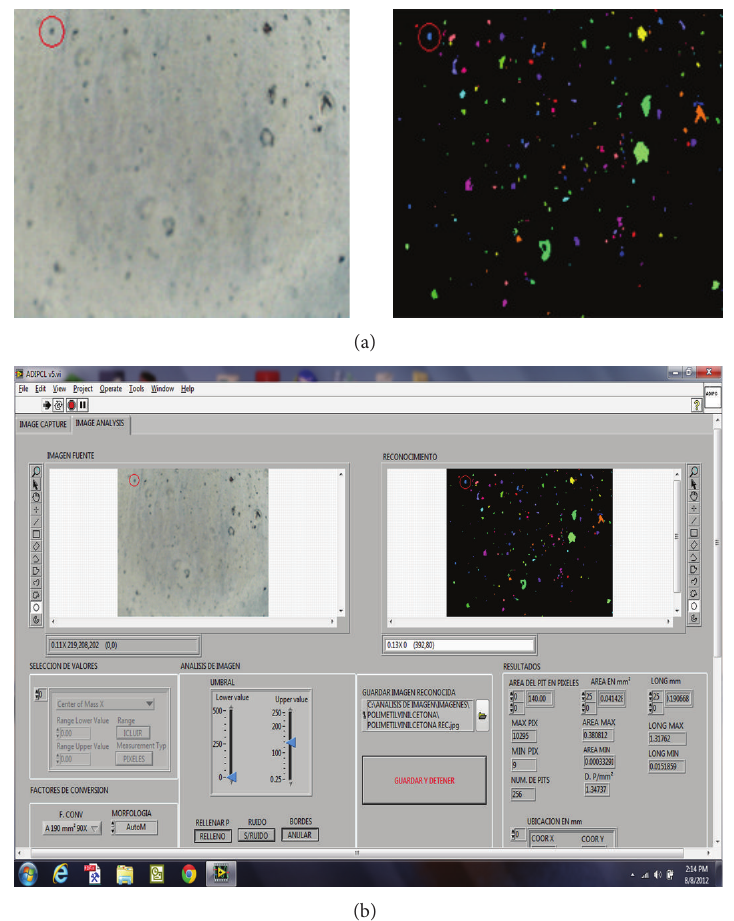
Figure 7: (a) Left: specimen microscope image; (a) right: map of the probable pits areas created by LCIA using the microscope image; (b) the LCIA user